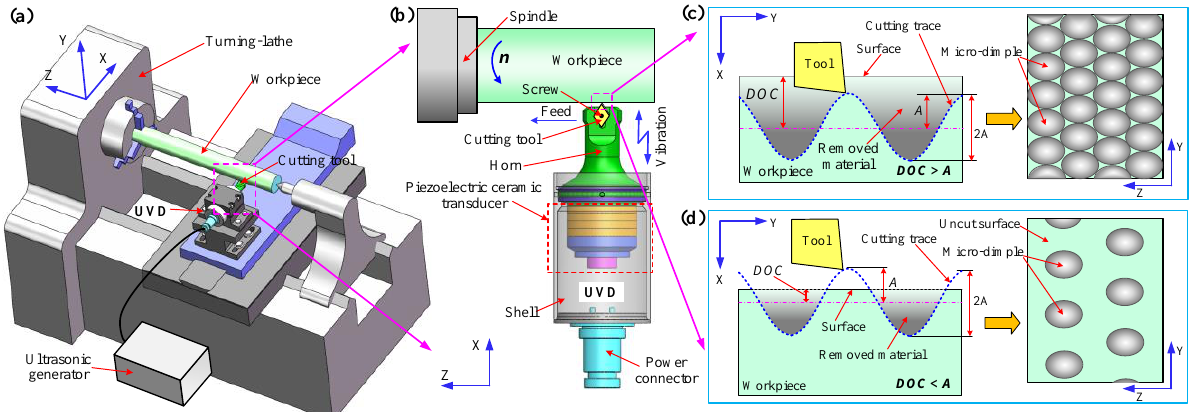
Figure 1. Illustration of surface texturing of 1D UVAT: ( a ) the overall assembly drawing of equipment for 1D UVAT; ( b ) principle of the texturing process; ( c ) continuous cutting condition ( DOC > A ); ( d ) intermittent cutting condition ( DOC < A ).